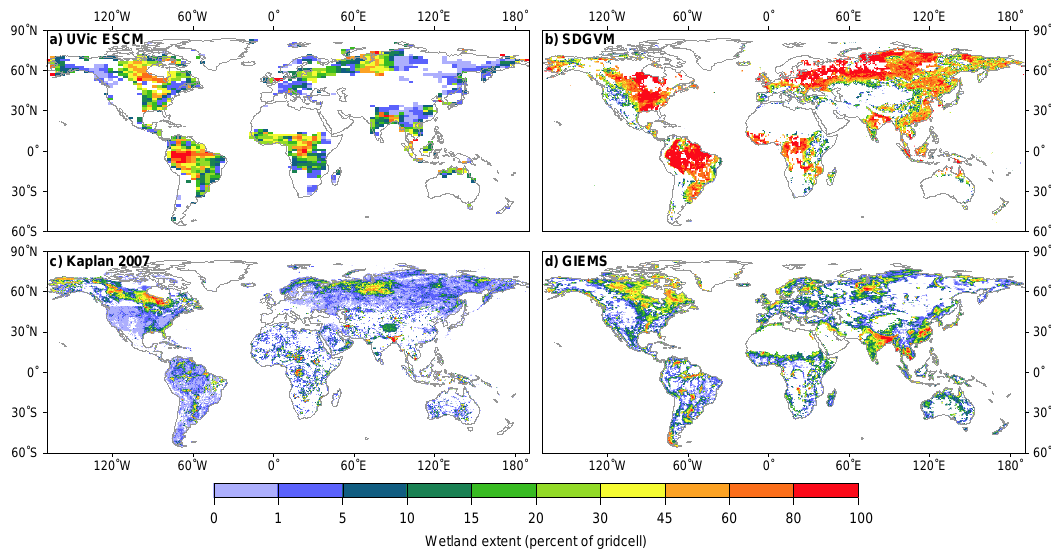
Fig. 1. Simulated mean annual maximal wetland extent for 1993–2004. The SDGVM and UVic-ESCM model results are from Experiment 2-Transient. The GIEMS inundation dataset is plotted as the mean annual maximum value across all years (1993–2004).